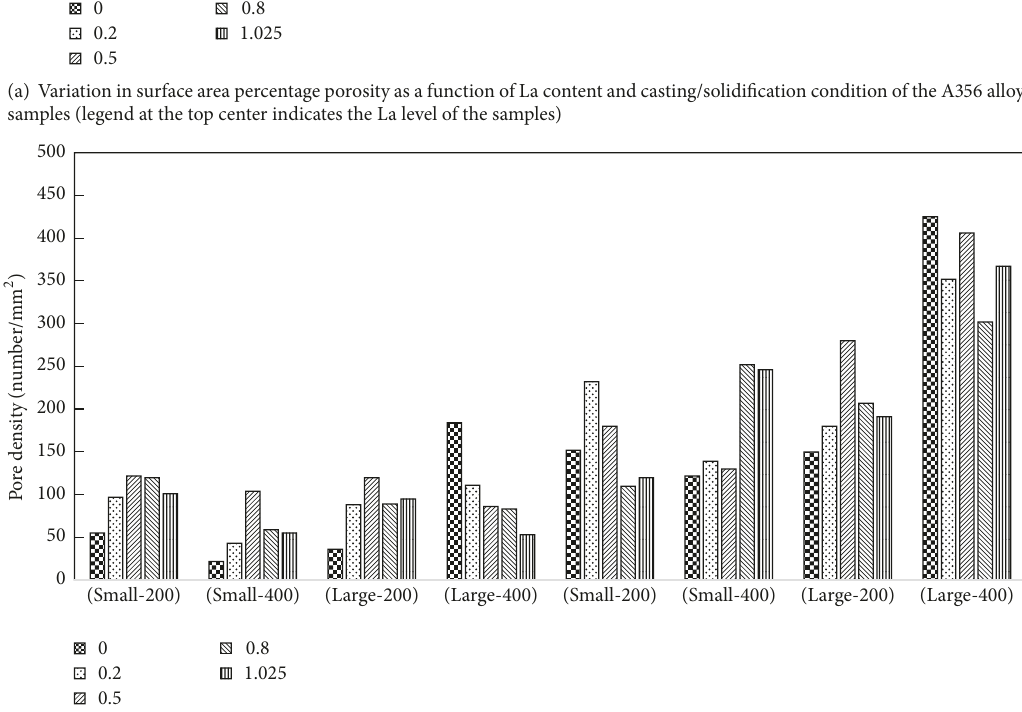
percentage of shrinkage